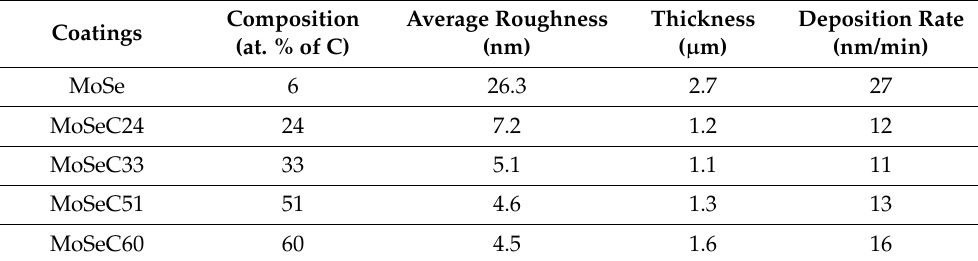
Table 2. Composition, roughness, thickness and deposition rate of the coatings based on WDS, AFM and SEM measurements,